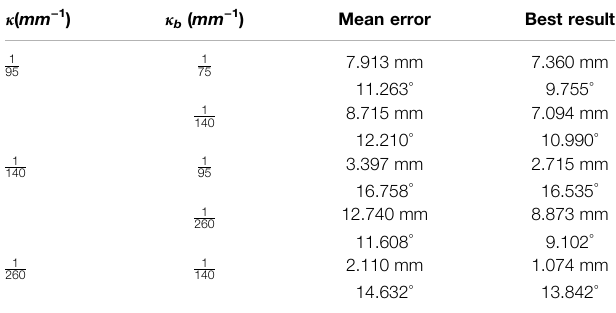
TABLE 3 | Results of spatial deformation.